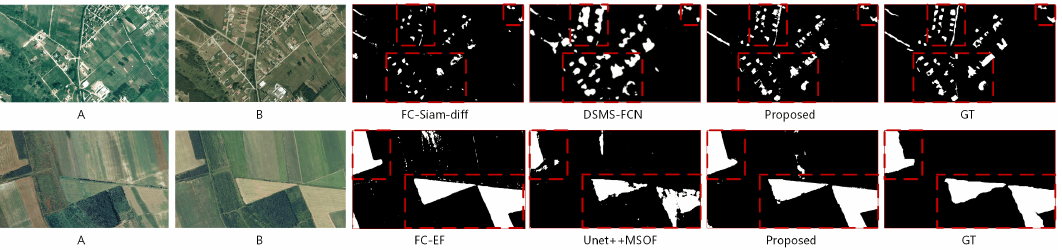
Figure 10. Illustration of our RCMs on SZTAKI with SOTA methods. Two rows show in order by SZADA/1 and TISZADOB/3, A and B mean the bi-tempral image pair. The comparing methods are FC-Siam-diff, DSMN-FCN, FC-EF and UNet++MSOF. In the first row, our RCM shows more accurate multiple winding shaped small areas describing, highlighted by the boxes. In both rows, our BA 2 Net represents GT-closer edges of the large range of changed